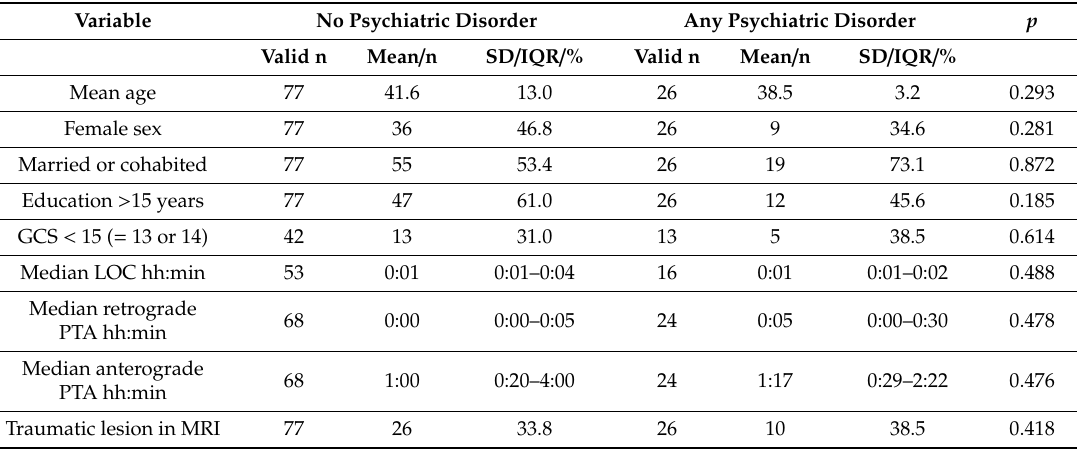
Table 2. Characteristics of the study population.